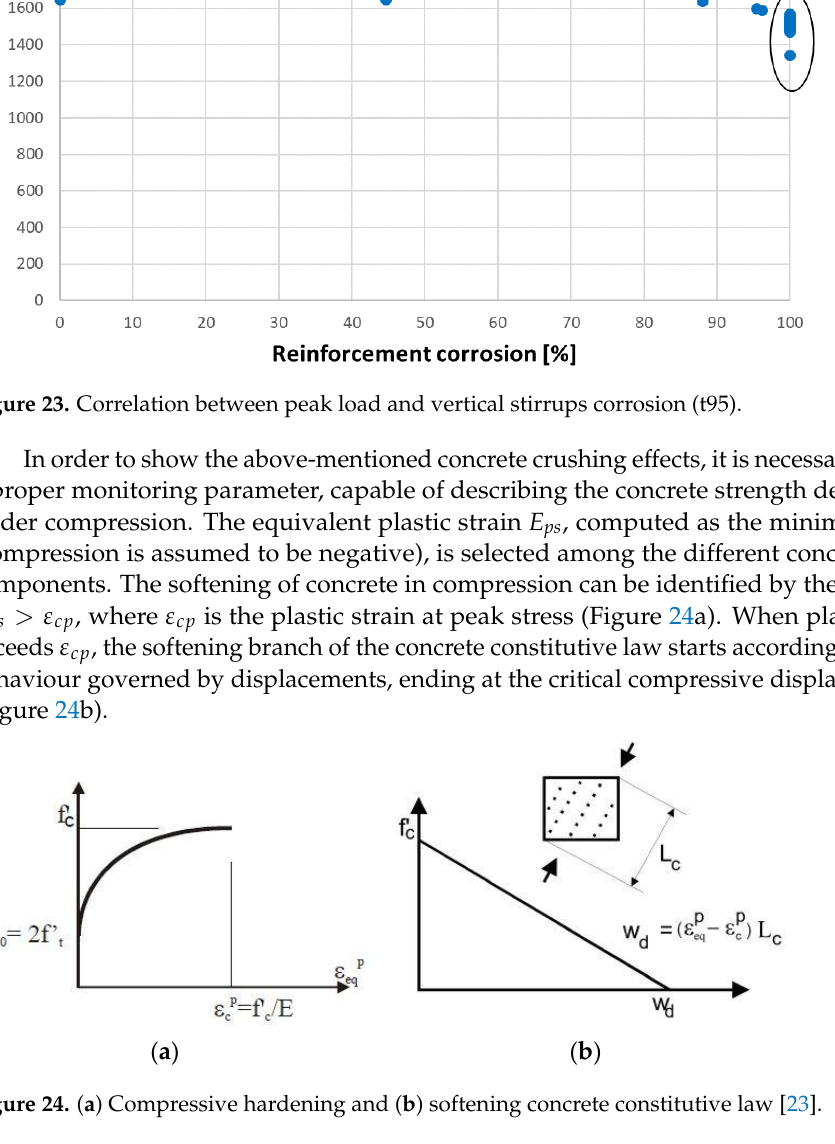
Figure 22. Correlation between peak load and reinforcement corrosion (t45).